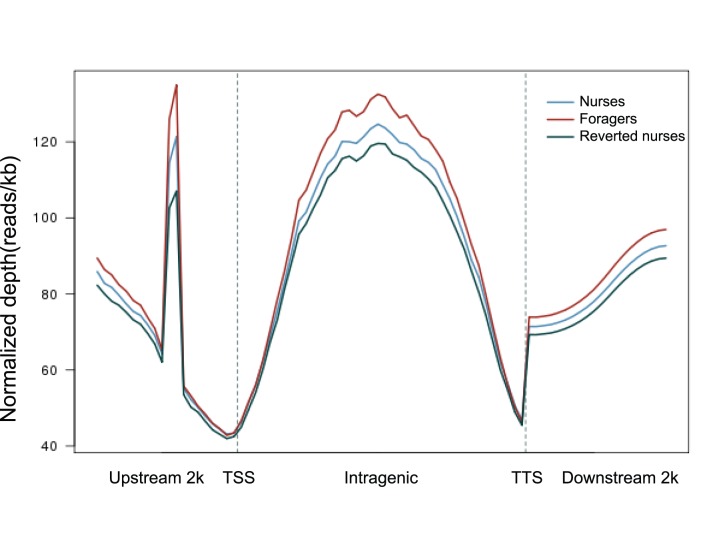
Distribution of reads around gene body.In upstream and downstream 2 kb regions, the regions were split into 20 equal regions. In the gene body, each gene was split into 40 equal regions. For each region, the normalized number of reads was calculated. “Y” axis is the average of normalized depth for each region.